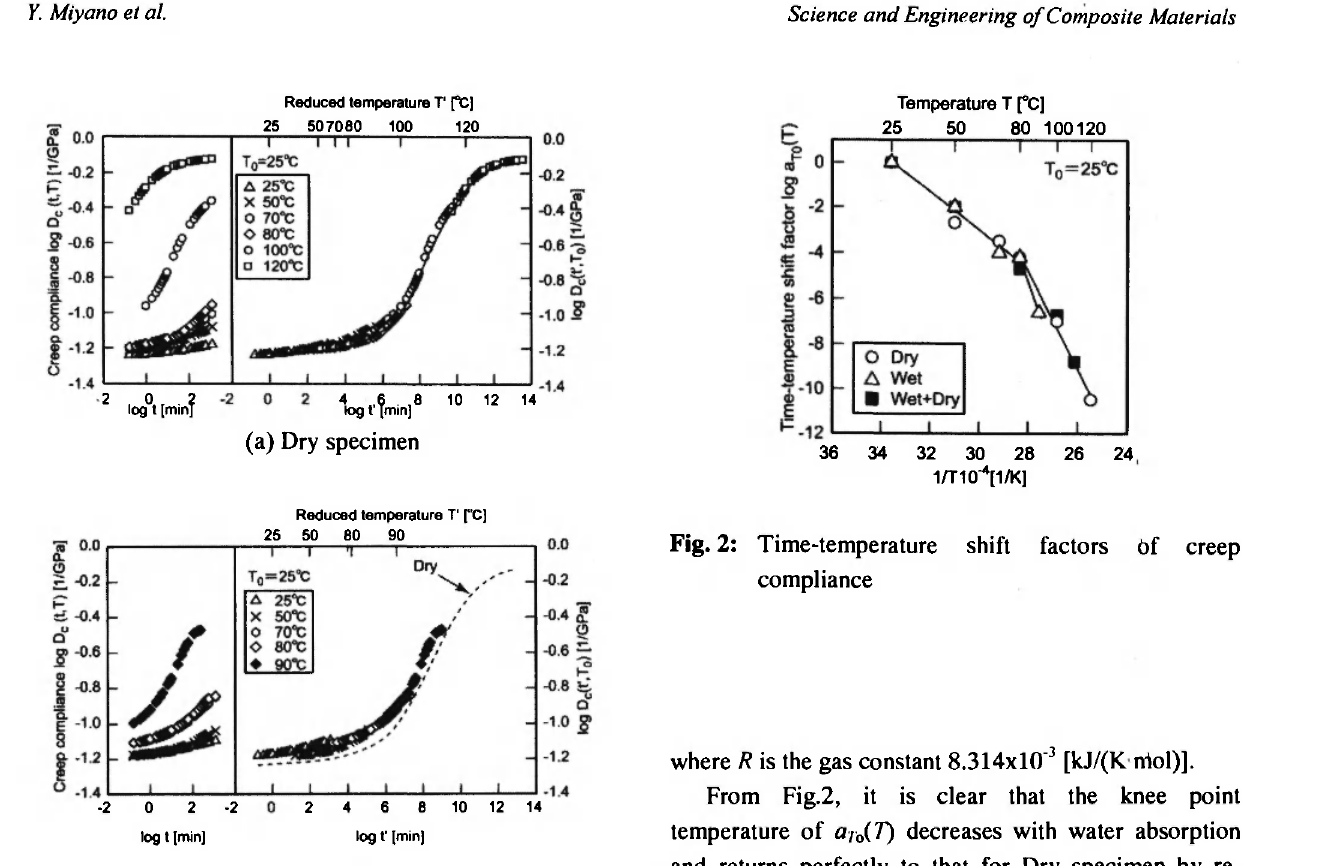
where R is the gas constant 8.314x10° [kJ/(Kniol)]. From Fig.2, it is clear that the knee point temperature of a ro (T) decreases with water absorption and returns perfectly to that for Dry specimen by re- drying after water absorption. The left side of Fig. 3 shows the master curves of D c for Dry, Wet and Wet+Dry specimens. Thd grand- master curve for D c versus the reduced-reduced time /" can be constructed by shifting the master curve D c for Wet specimen along the log scale of f so that they overlap on D c at the reference water content W 0 =0% (Dry specimen) to form a single smooth grand-master curve as shown in the right side of this figure. Therefore, the TTWSP is applicable for £> c .